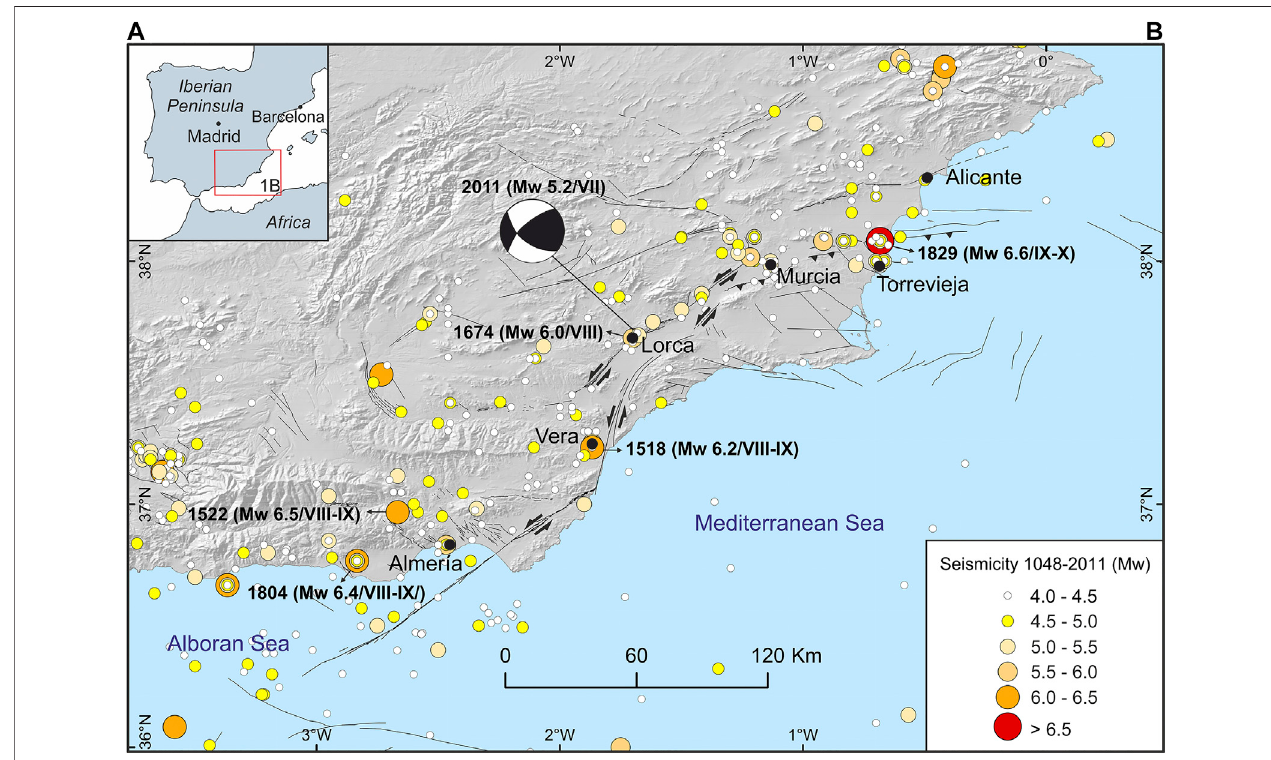
FIGURE 1 | (A) Location of the study region within the Iberian Peninsula; (B) Seismotectonic context of SE Spain with the seismicity of Mw ≥ 4.0 from the 1048 – 2011period (IGN-UPM,2013),including themostdamaginghistorical earthquakesoftheregionpointed withanarrow. Thefocalmechanismofthe2011Mw5.2 Lorca earthquake is extracted from the Instituto Geográ fi co Nacional agency (IGN, 2011). Intensity scale is European Macroseismic Scale (EMS98). The main traces of the Quaternary active faults are extracted from QAFI v.3. Database (IGME, 2015a; García-Mayordomo et al., 2017).